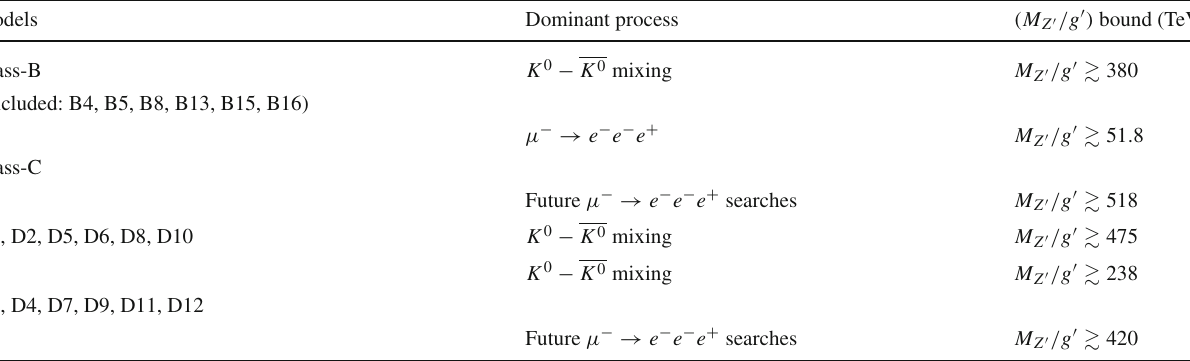
Table 19 Dominant flavour violation process for each model along with the corresponding bounds on the mass of the flavour mixing Z (cid:2) boson